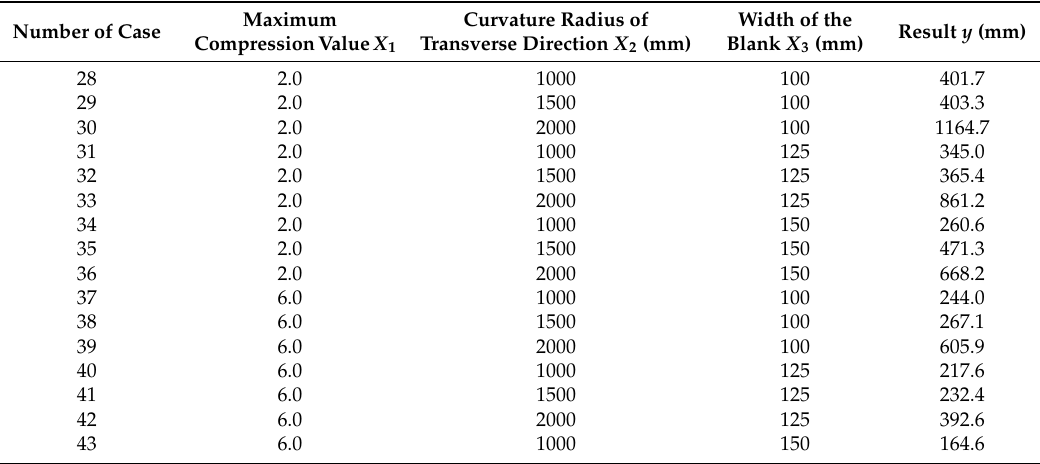
Table 4. Statistical table for saddle